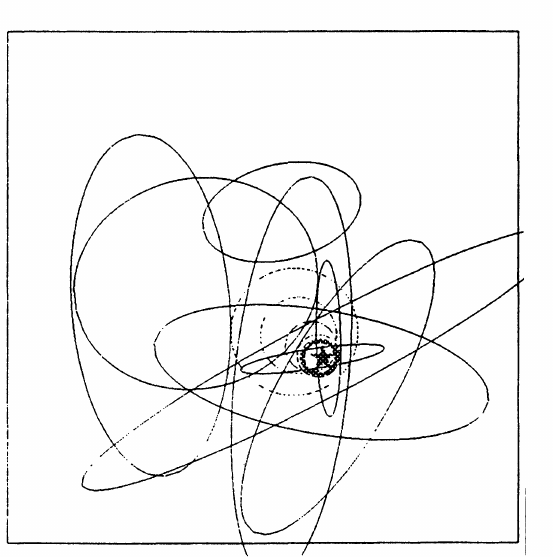
FIGURE 3 (a) Global minimum search by a standard method and (b) the elastic net method.